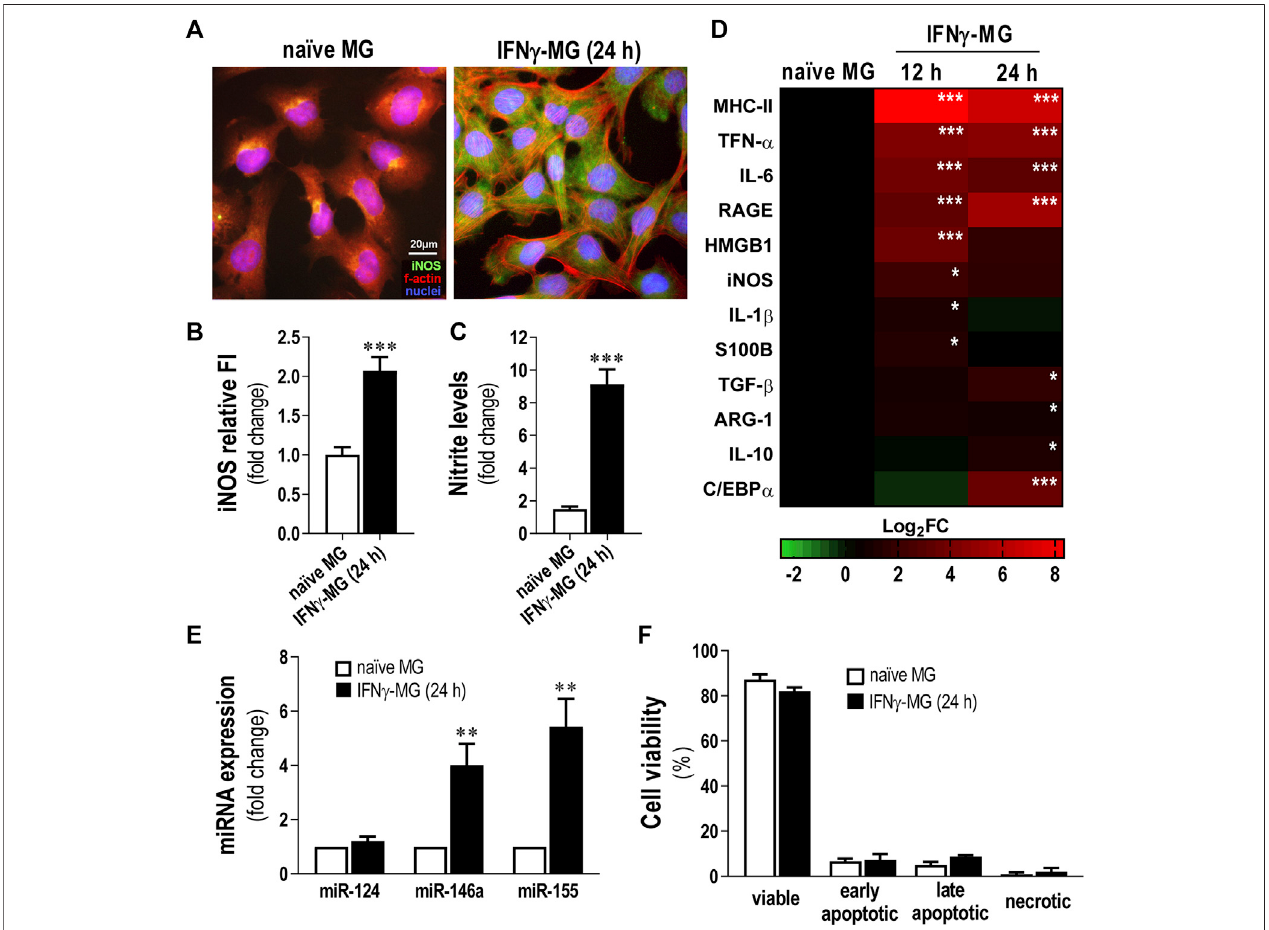
FIGURE 2 | Reactive pro fi le of CHME3 human microglia upon stimulation with IFN γ . Human microglia CHME3 were either non-treated (naïve) or stimulated with IFN γ for12 hor24 handassessedforseveralbiomarkers,asindicatedinthe MaterialsandMethods Section. (A) Representative fl uorescenceimagesofmicroglialiNOS (green) and f-actin (red). Cell nuclei are stained with Hoechst 33258 dye (blue). (B) Quanti fi cation of iNOS relative cell fl uorescence intensity (FI). (C) Evaluation of nitrite accumulation in the cell media. (D) Heatmap representation of in fl ammatory-associated genes in microglia after 12 and 24 h of IFN γ stimulation. (E) Expression levelsofthemiRNAsassociatedwithin fl ammation. (F) MicrogliaviabilitybyNexin fl owcytometryassay.Fourcellpopulationsweredistinguished:viable(V-PEand7-AAD double-negative), early apoptotic (V-PE positive and 7-AAD negative), late apoptotic (V-PE and 7-AAD double-positive), and necrotic cells/cellular debris (V-PE negative and 7-AAD positive). Results are mean ± SD from at least three independent experiments. ** p < 0.01 and *** p < 0.001 vs . naïve MG, two-tailed Student ’ s t -test. MG; CHME3 human microglia cells; IFN γ -MG, IFN γ -stimulated CHME3 human microglia cells; f-actin, fi lamentous-actin; iNOS, inducible nitric oxide synthase; miR, miRNA; h, hours; MHC-II, major histocompatibility complex – class II; TNF- α , tumor necrosis factor α ; IL, interleukin; RAGE, receptor for advanced glycation end products; HMGB1, high mobility group box protein 1; S100B, S100 calcium-binding protein B; TGF- β , transforming growth factor β ; ARG-1, arginase-1; C/EBP α , CCAAT enhancer binding protein α